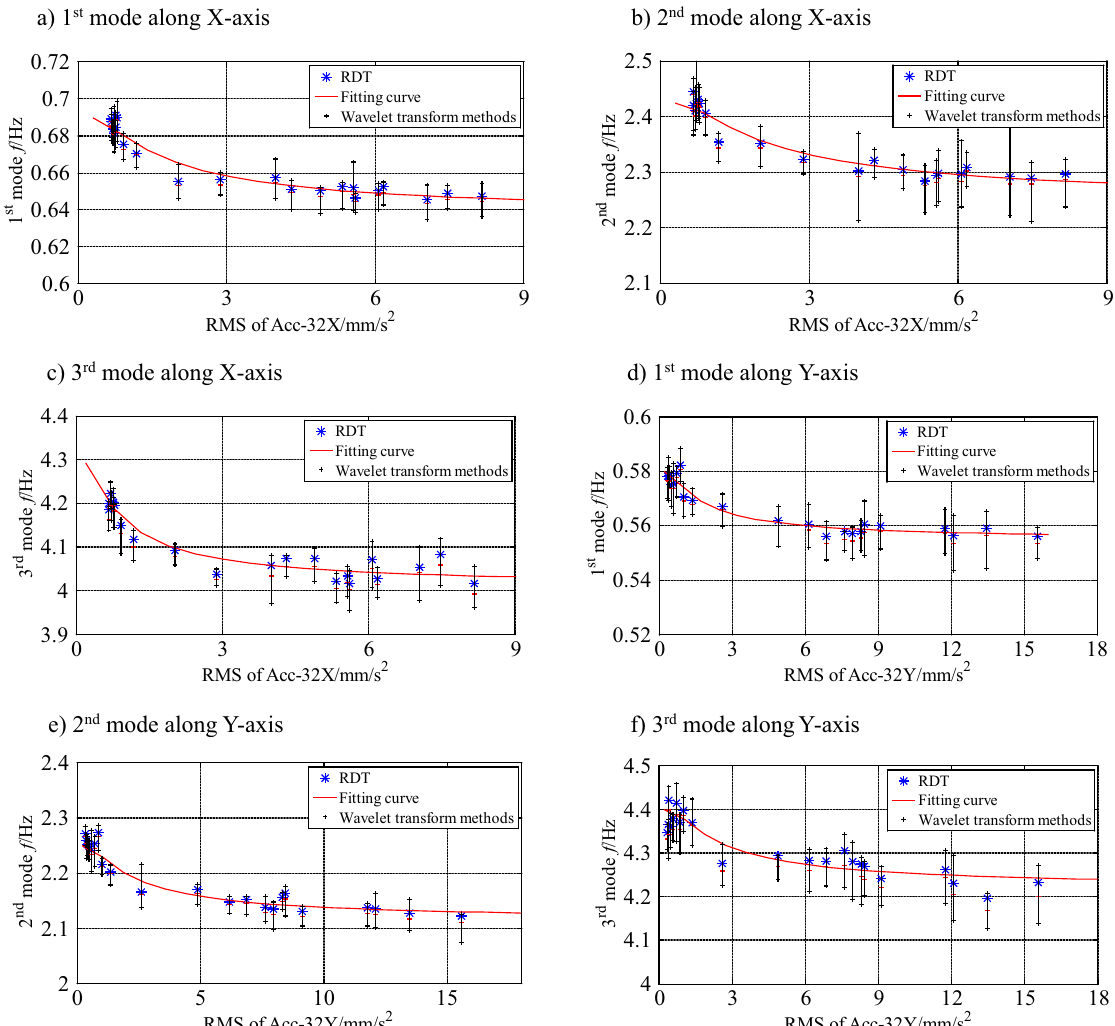
Figure 15. The relationship between modal frequency and RMS of Acc at the top